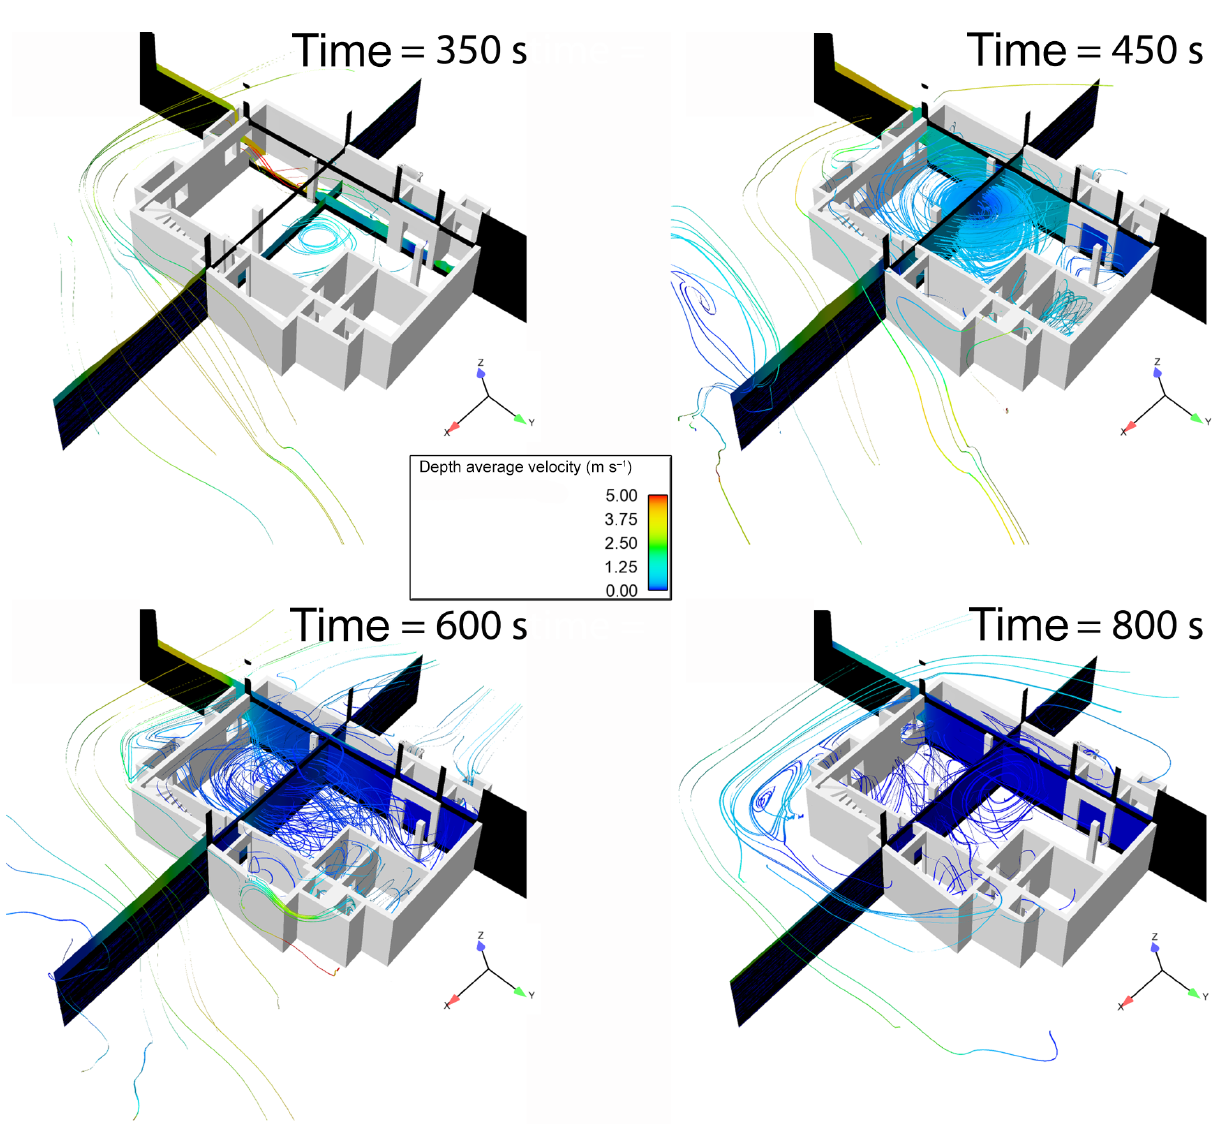
Figure 7. Scenario (b) after 350, 450, 600 and 1020s of simulation – 2-D sections and streamlines with depth averaged velocity contours (ms − 1 ), illustrating flow paths and characteristics of in- and outflow of the building (stl-geometry of the